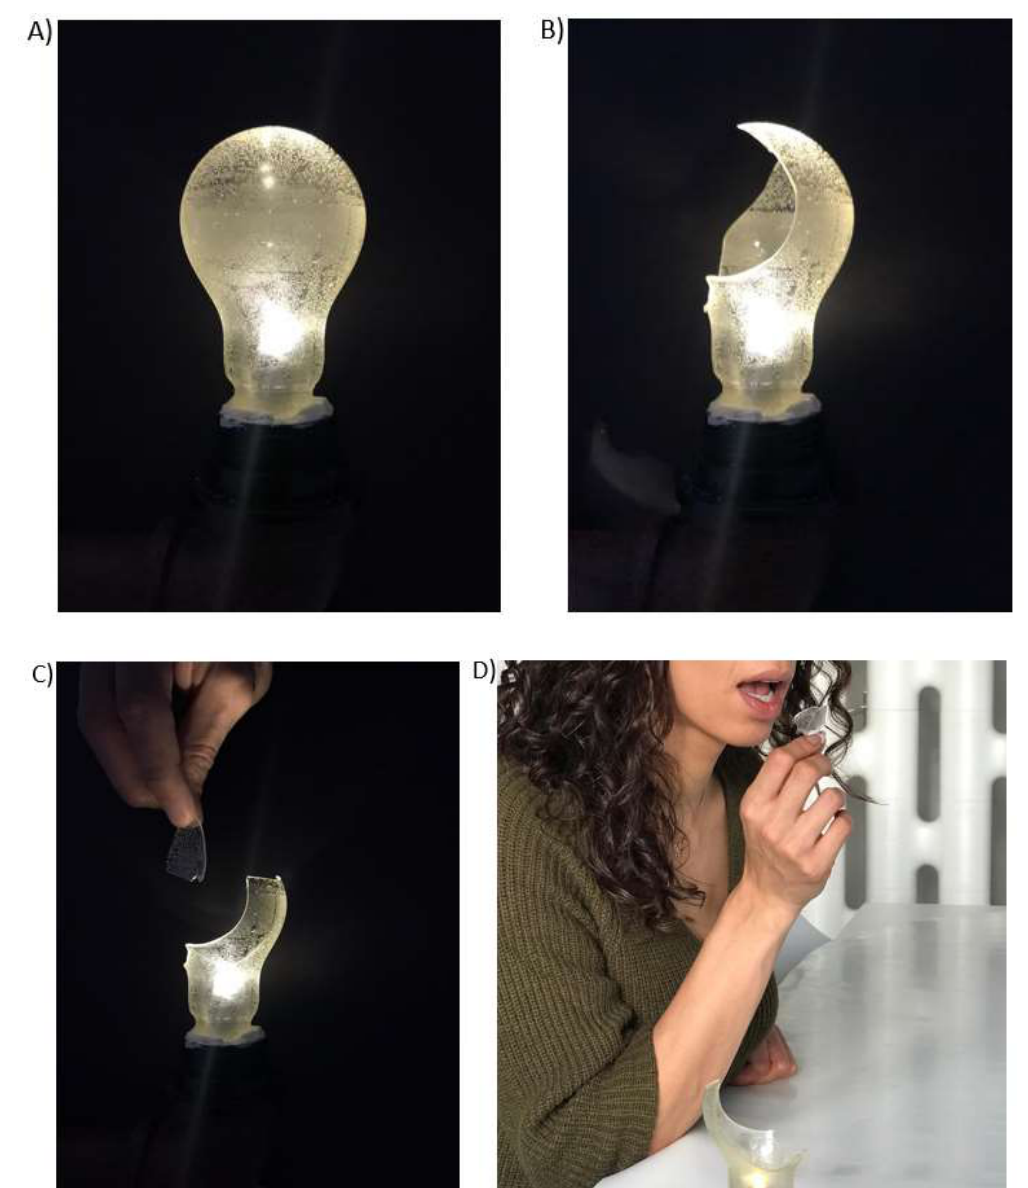
Figure 6. The edible lightbulb dish as served at Kitchen Theory’s Gastrophysics Chef’s Table. ( A – D ) from presentation to consumption.